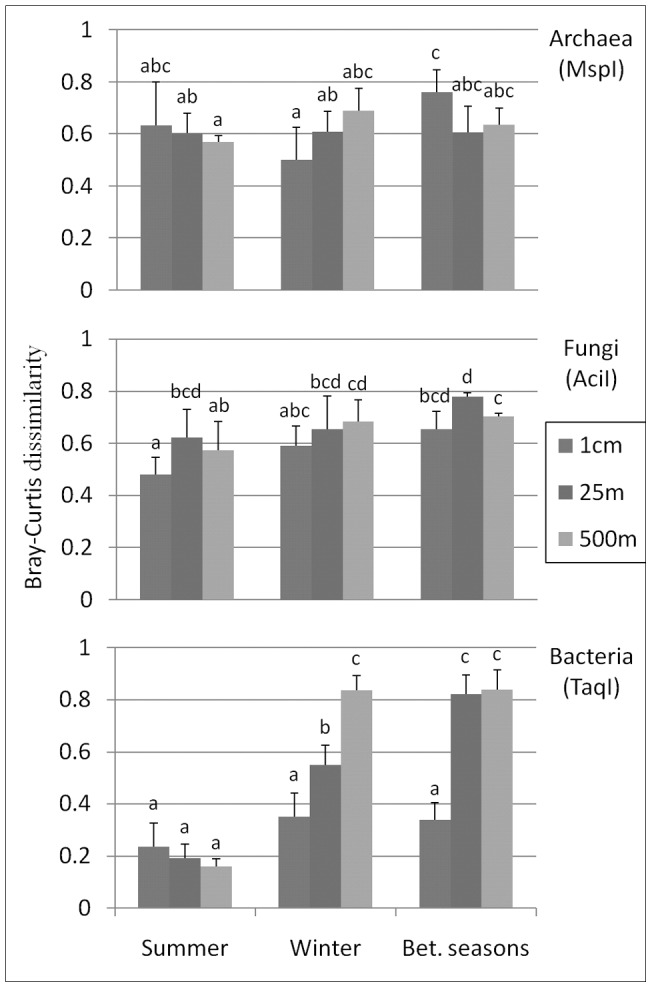
Differences in community structure between samples separated by different geographic distances and seasons.Bray-Curtis dissimilarity = 1 indicates that communities are very different, whereas Bray-Curtis dissimilarity = 0 indicates that communities are very similar. Each marker was studied using three restriction enzymes; only one is depicted here (and its name is given in parentheses), but for each marker, the overall pattern was very similar using the other two restriction enzymes (data not shown). Different letters indicate significant groupings. Bet., between.